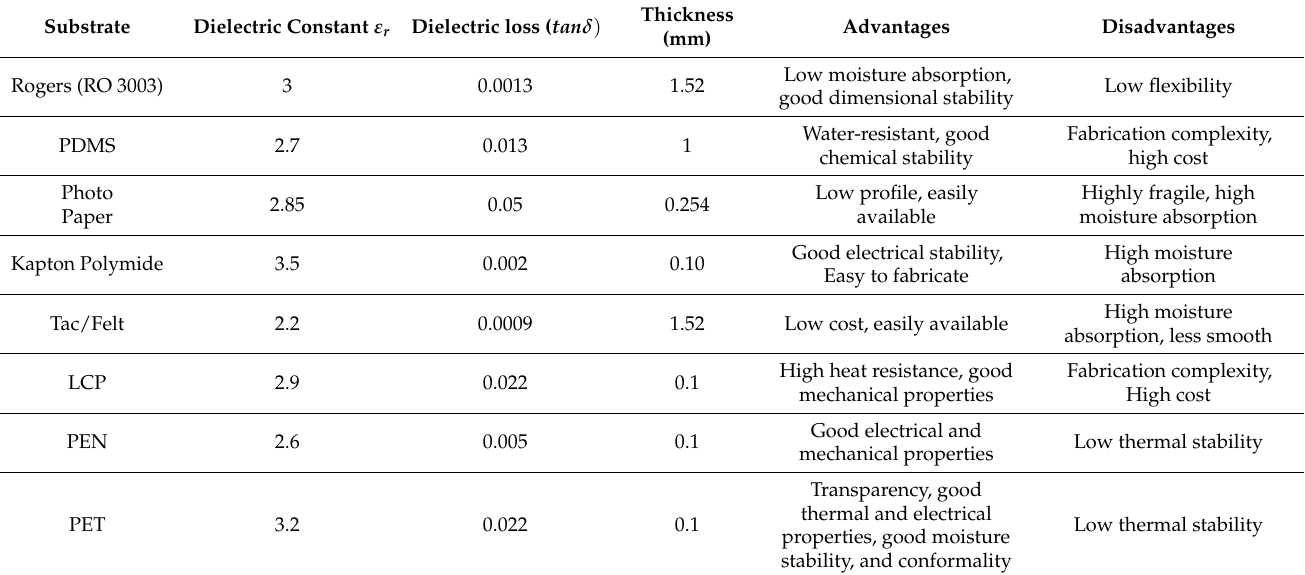
Table 4. Comparison of the various substrate materials in flexible antenna